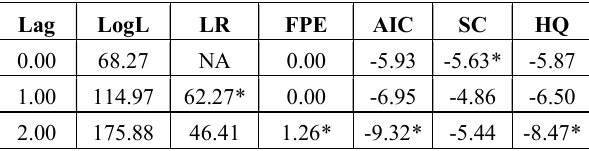
Table 1. VAR Lag Order Selection